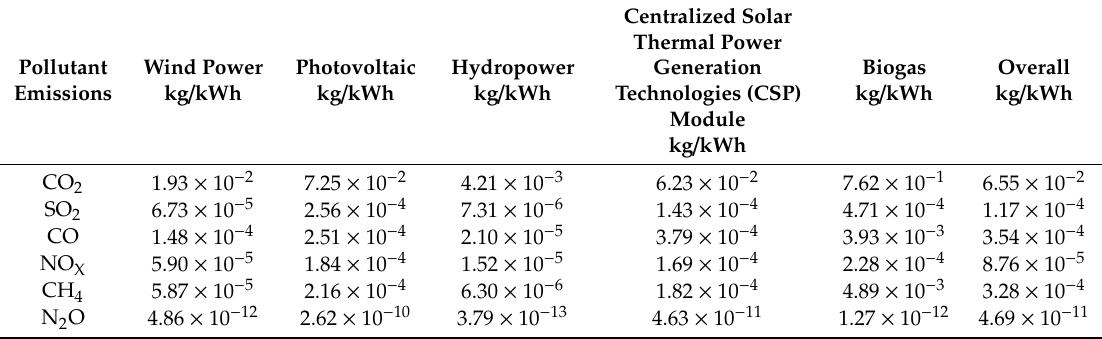
Table 3. Typical pollutant emissions quantity to environment directly for each power generation technology and overall system with function unit.